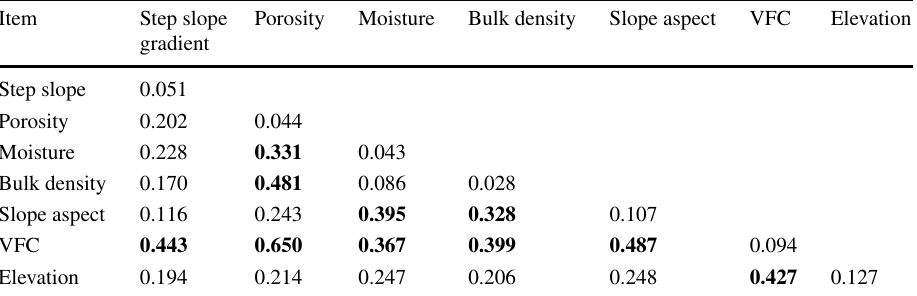
Values in bold are stronger than